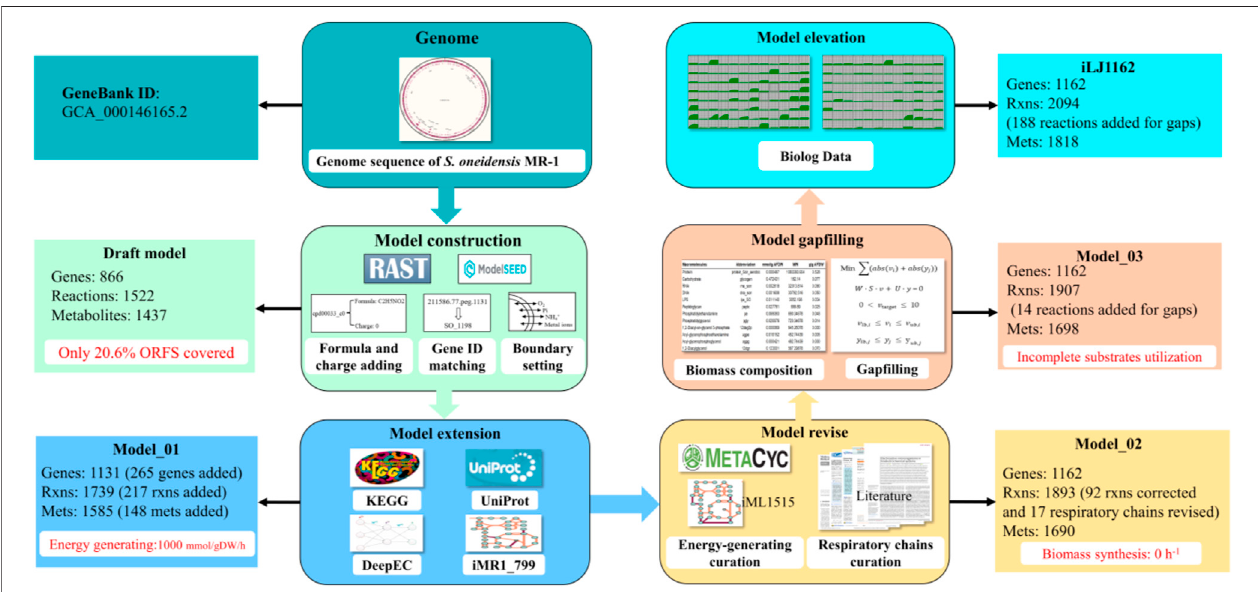
FIGURE 1 | Work fl ow of the genome-scale metabolic network reconstruction